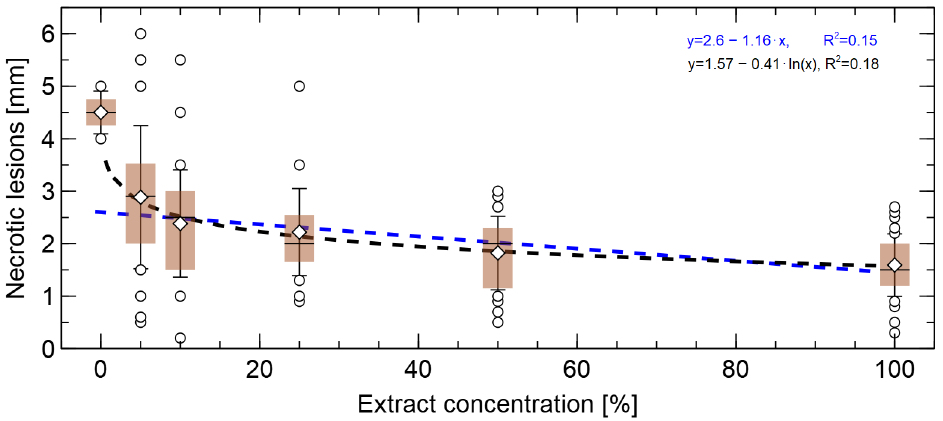
Figure 1. The relation between necrosis length and extract concentration for all measured roots samples. The concentration of 0% represents the control. The box spans from the 1st to 3rd quan- tile. Horizontal line in the box represents sample median, diamond sign represents mean value, the whiskers show standard deviation from the mean, and the circles outside whiskers represent outlier observations. The blue and black dashed lines represent regression fit lines, for which the corresponding parameters and R 2 values are typed in the figure. The p -values for all regression coefficients are below